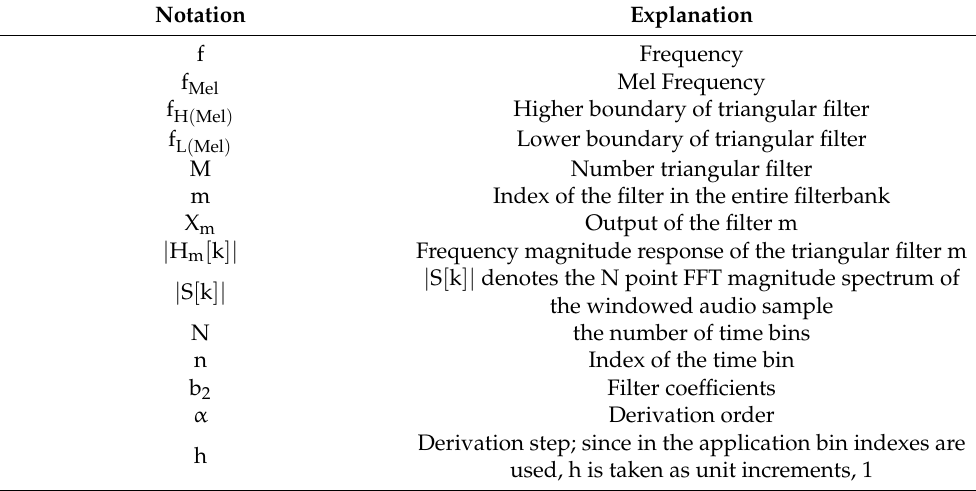
Table 1. List of some notations that are used for explaining Mel spectrogram representation and, Grünwald–Letnikow and Riemann–Liouville definitions of fractional